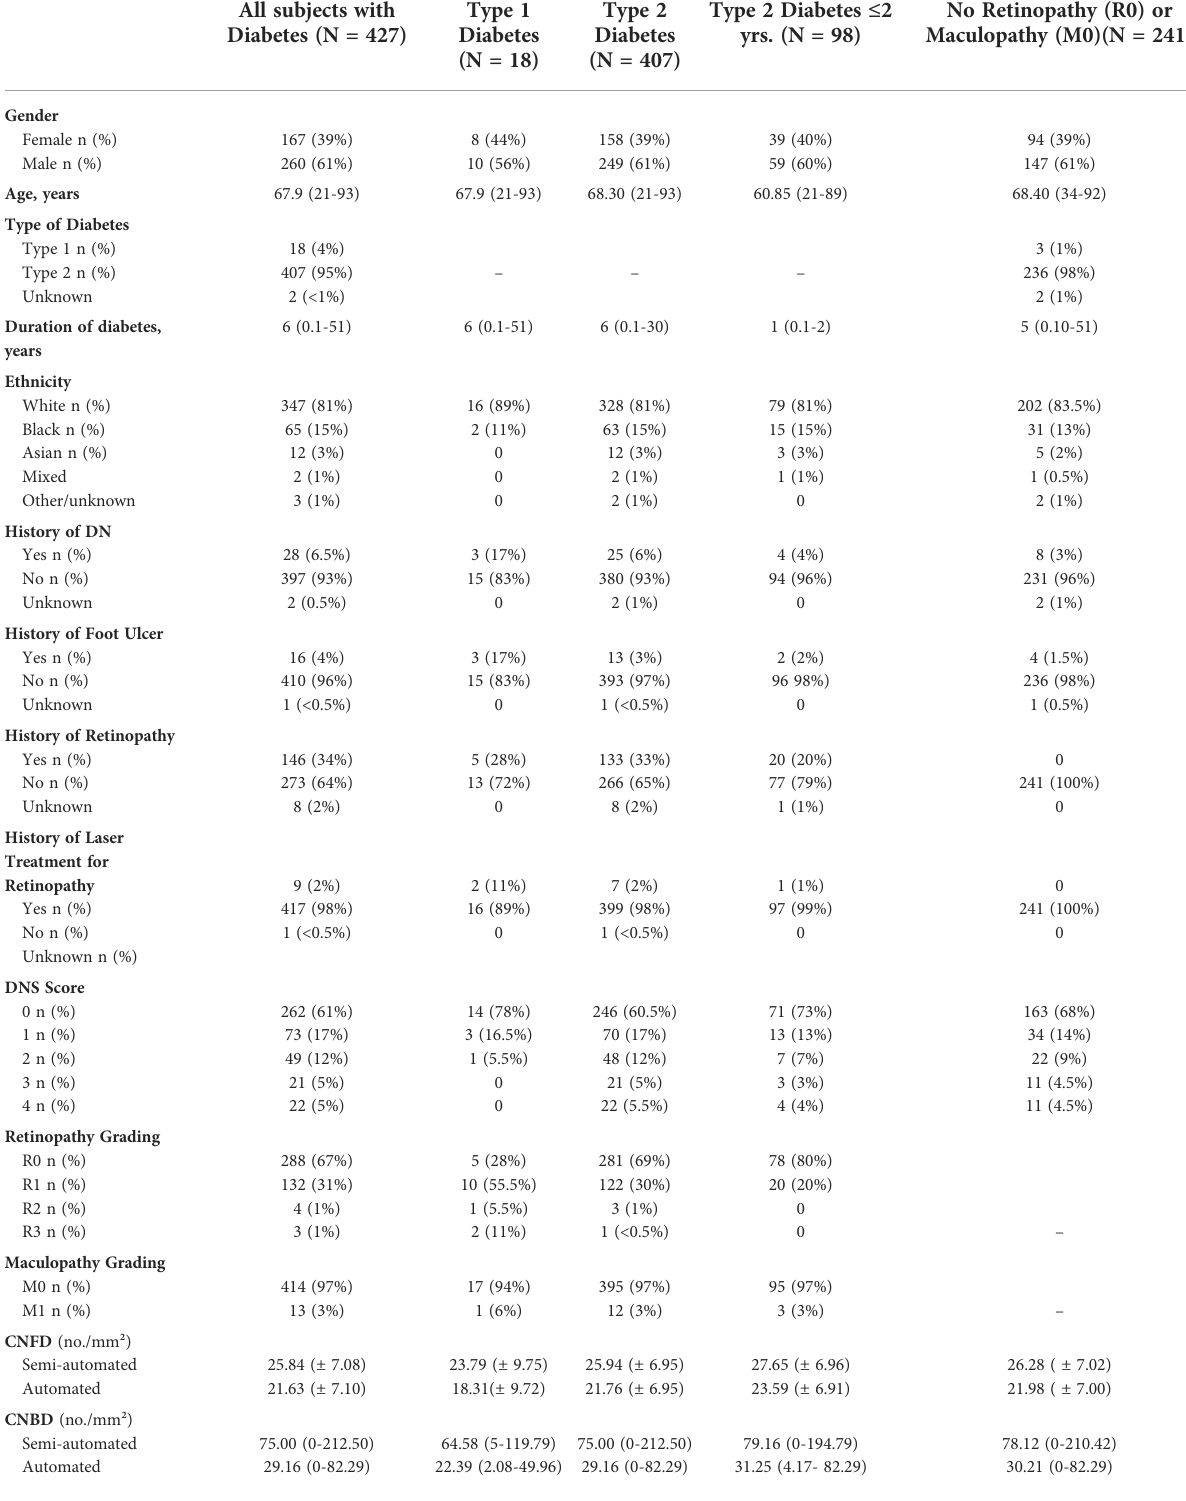
TABLE 1 Characteristics of the cohort with